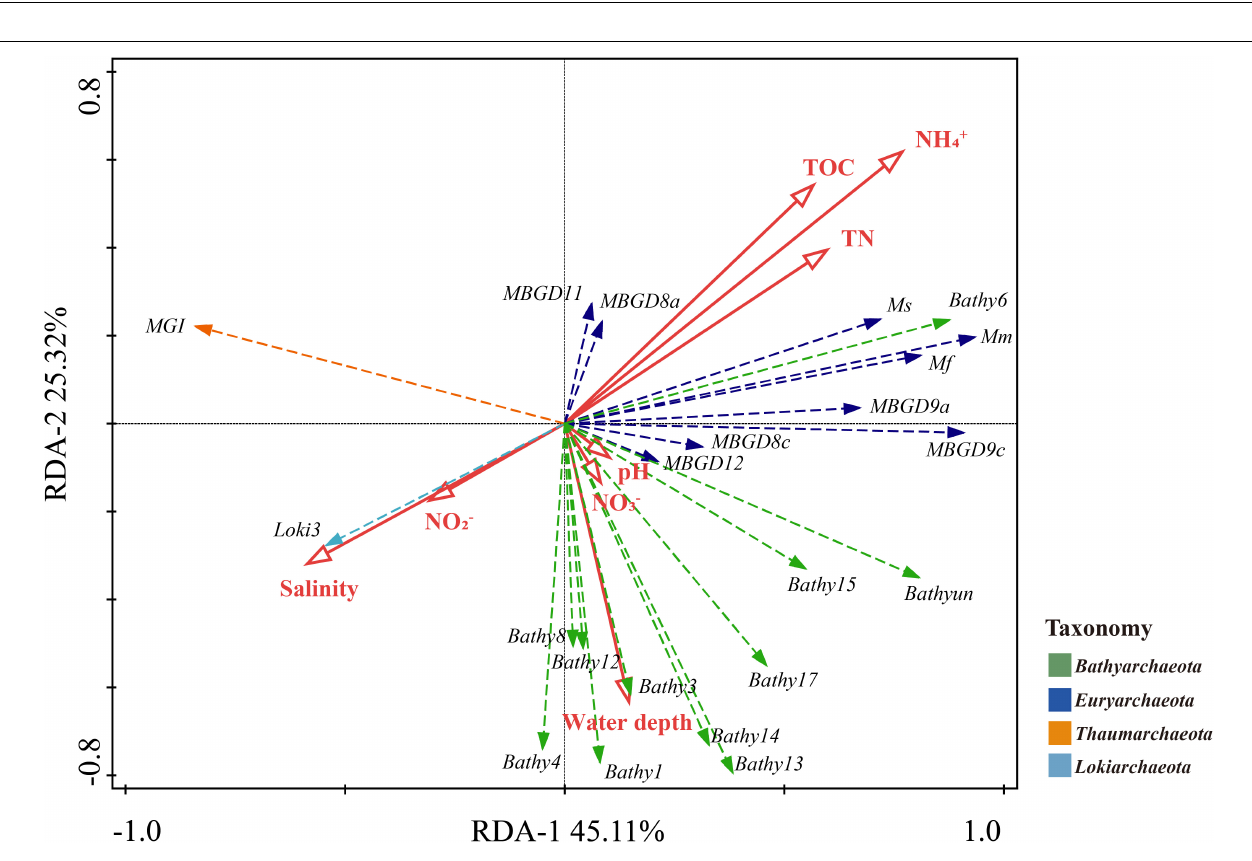
FIGURE 3 | The abundance of archaeal and bathyarchaeotal 16S rRNA genes in each sample. Light blue bars, the total archaea; dark blue bars, the Bathyarchaeota .